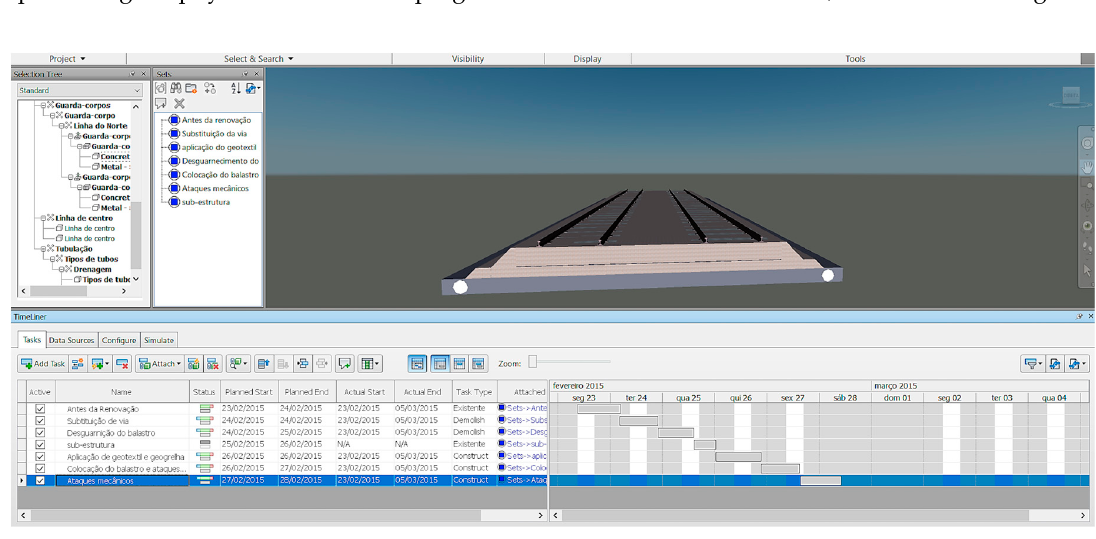
Figure 8. Interface of Navisworks®: generation of the 4D BIM model.